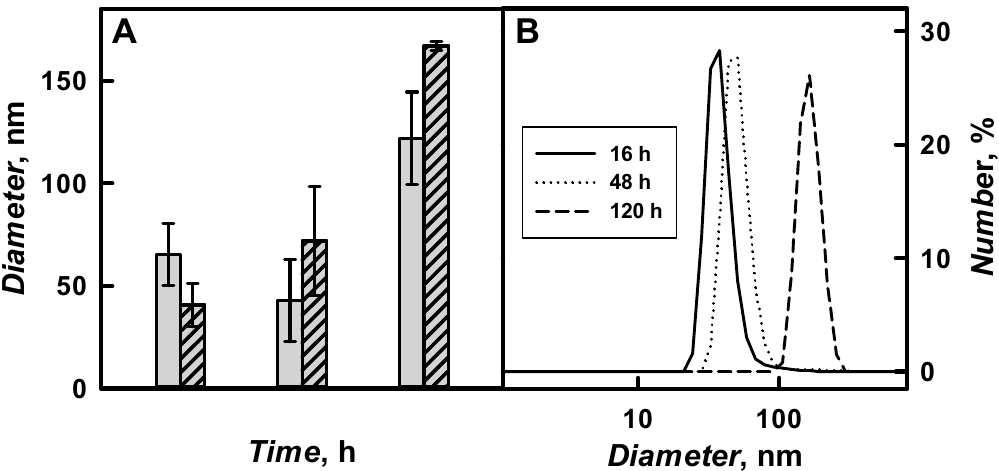
Figure 9. The influence of enzymatic polymerization duration on the diameter of formed PANI/GOx (dash column) and Ppy/GOx (grey column) composite nanoparticles ( A ) and the distribution of PANI/GOx nanoparticles diameter after 16, 48, and 120 h polymerization ( B ). (The composition of polymerization solution: 0.05 mol L − 1 SA buffer, pH 6.0, with 0.05 mol L − 1 of glucose, 0.50 mol L − 1 of aniline or pyrrole, and 0.75 mg mL − 1 of glucose oxidase. DLS signal was registered in 0.05 mol L − 1 SA buffer, pH 6.0). Table 2. The characteristics of PANI/GOx and Ppy/GOx composite nanoparticles depending of the polymerization duration determined by DLS. (Conditions like in Figure 9, SD—standard deviation.). Time , h